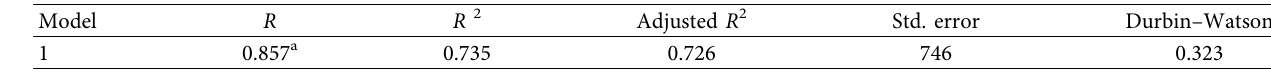
Table 3: Linear regression summary.